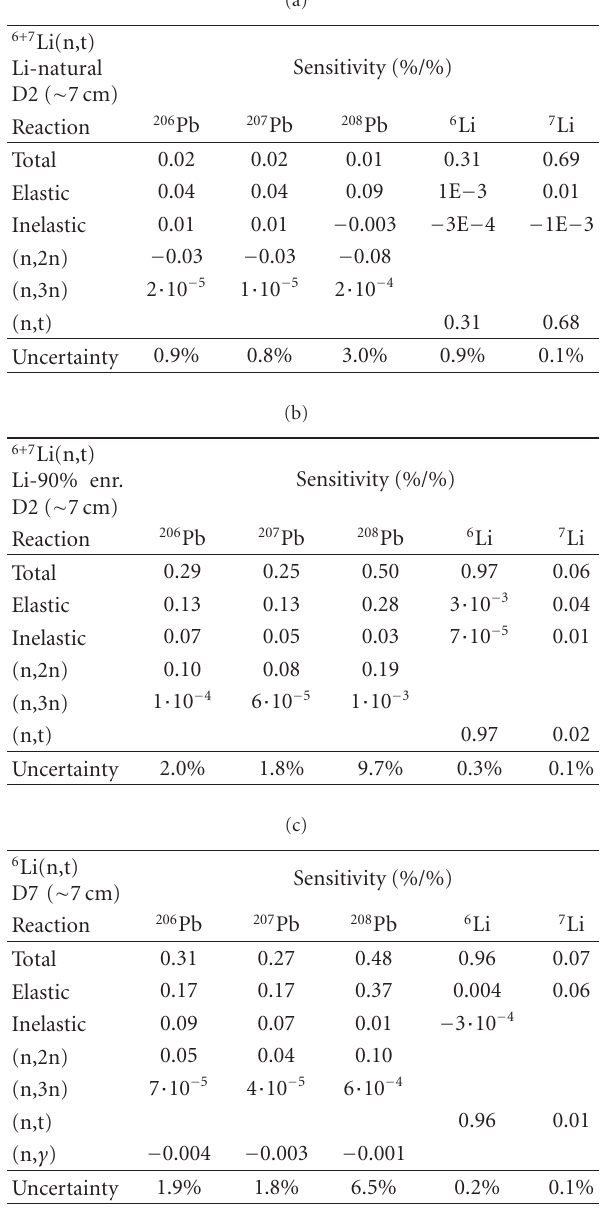
Table 5: Sensitivity of the TPR to cross-sections for two detector positions. Both natural and 90% enriched Li were considered (SUSD3D results based on the DORT 2D neutron